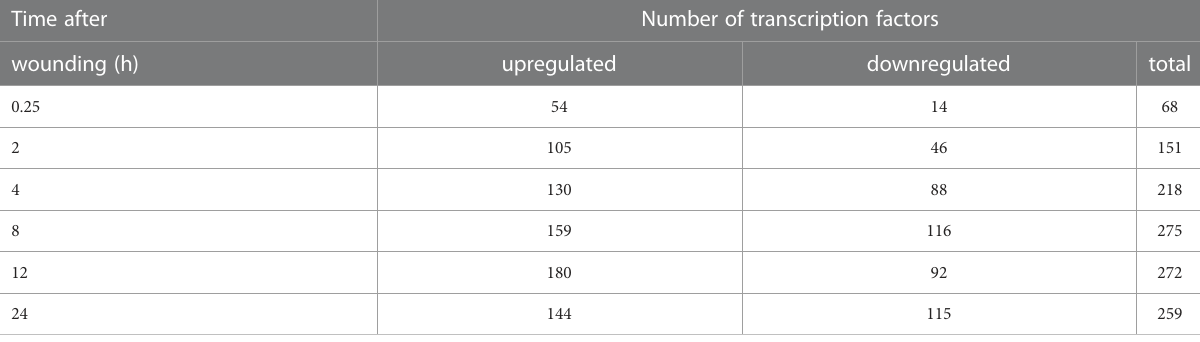
TABLE 2 Number of differentially expressed transcription factors in wounded sugarbeet taproots as a function of time after wounding. Time after Number of transcription factors wounding (h) upregulated downregulated total